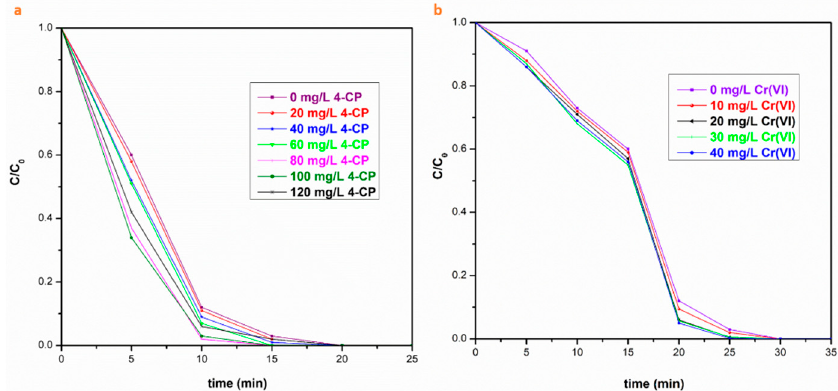
Figure 10. ( a ) Effect of initial 4-CP concentration on Cr(VI) removal by MFNNs. (Experiment conditions: [Cr(VI)] 0 = 10.0 mg/L, [MFNNs] = 0.20 g/L, [H 2 O 2 ] 0 = 4.90 mM, pH = 3.0). ( b ) Effect of initial Cr(VI) concentration on 4-CP removal by MFNNs. (Experiment conditions: [4-CP] 0 = 100.0 mg/L, [MFNNs] = 0.20 g/L, [H 2 O 2 ] 0 = 4.90 mM, pH = 3.0).